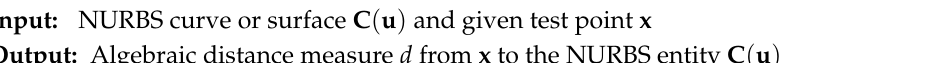
Algorithm 1 Algebraic level sets